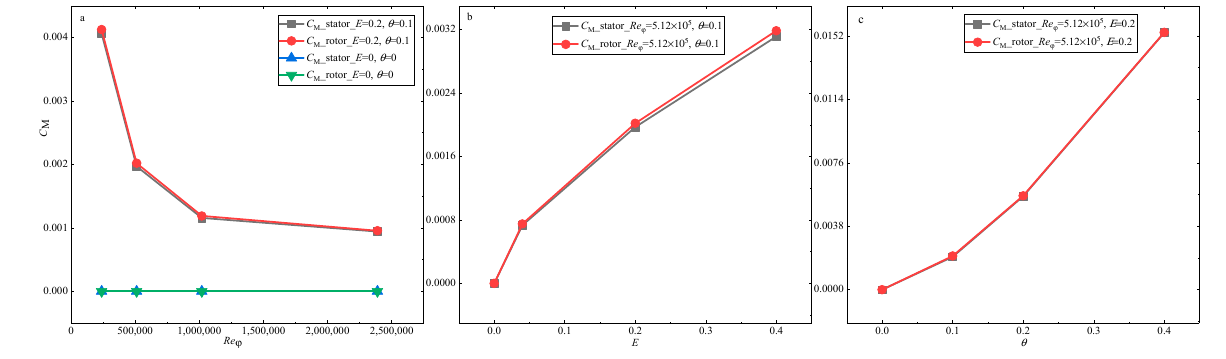
Figure 24. Moment coefficient of rotor and stator on the ϕ = π /2 + θ /2: ( a ) E = 0.2, θ = 0.1; ( b ) Re ϕ = 5.12 × 10 5 , θ = 0.1; ( c ) Re ϕ = 5.12 × 10 5 , E =